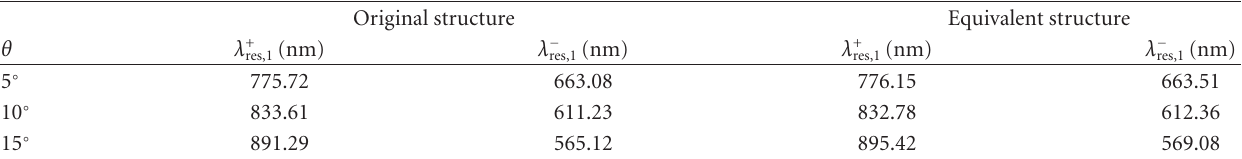
Table 2: Comparison of the resonant wavelengths obtained by the analysis of the original structure with di ff erent angles of incidence and its equivalent